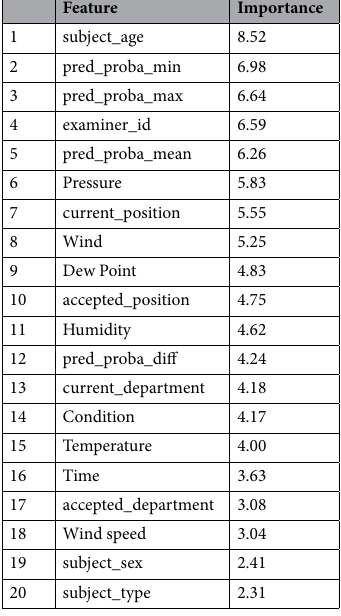
Table 4. Feature importance of the second-level basic model with alt data.